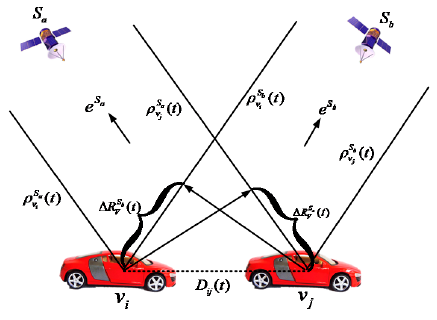
Figure 7. Double differencing distance.